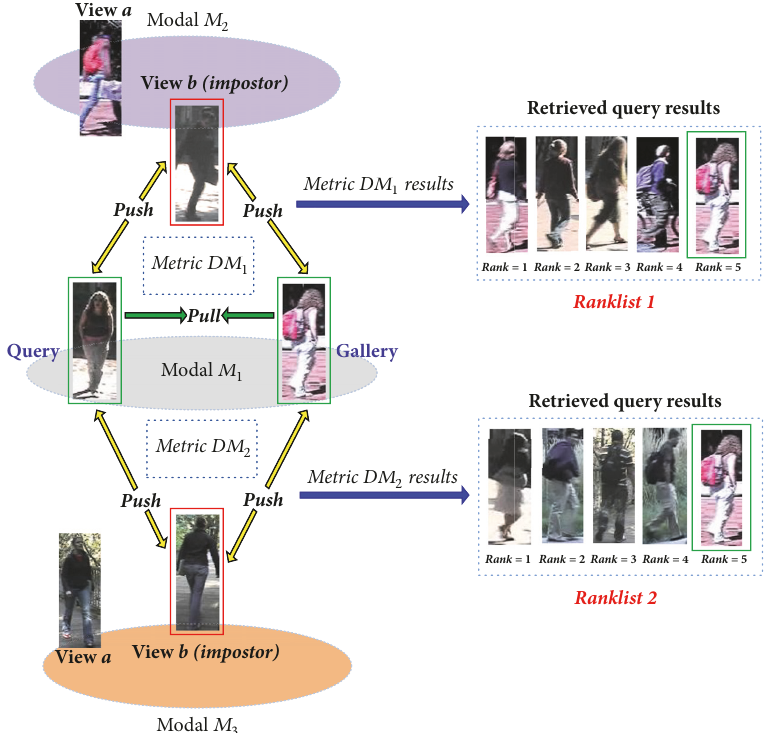
Figure 1: Three Modals 𝑀 1 , 𝑀 2 , and 𝑀 3 in Image Space. Query and Gallery lie in modal 𝑀 1 , while one impostor for query lies in modal 𝑀 𝑀 𝐷𝑀 2 and the other in modal 3 . Metric 1 is learned using the impostor from modal modal 𝑀 3 . Then, the obtained retrieval results of 𝐷𝑀 1 and 𝐷𝑀 2 are shown in Ranklist 1 and Ranklist 2 , respectively. Correct Match is in green